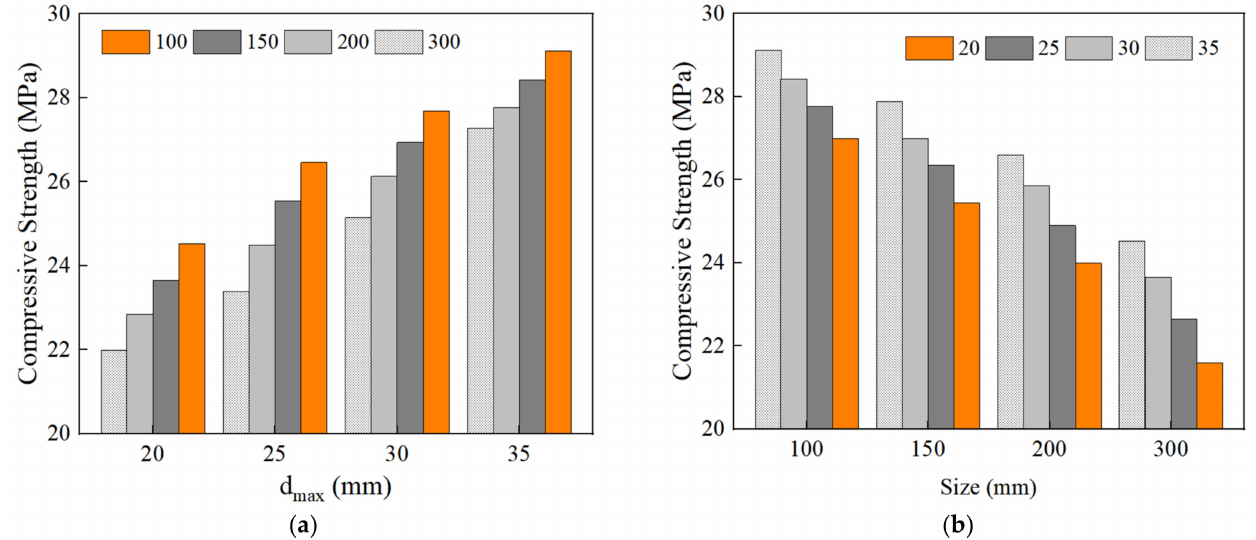
Figure 20. The effect of the maximum aggregate size on the compressive strength of RAC. ( a ) The effect of the maximum aggregate size on the compressive strength of RAC; ( b ) the effect of the specimen size on the compressive strength of RAC.